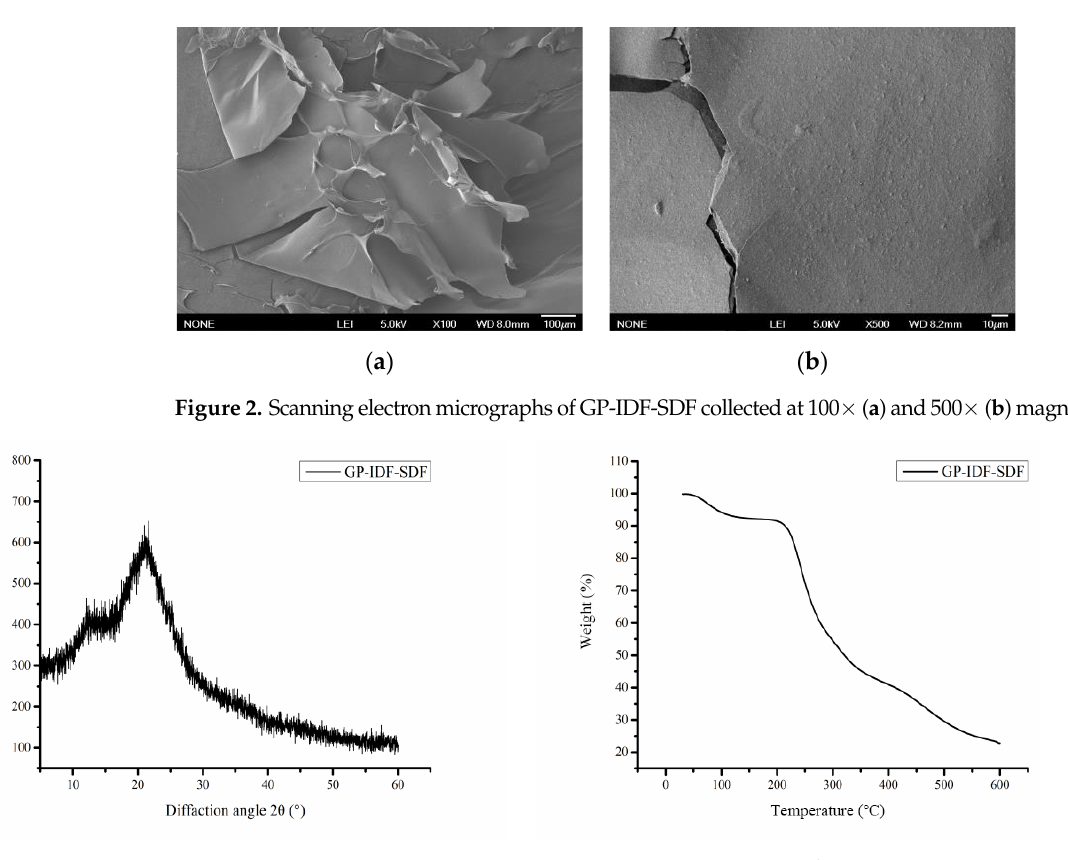
Figure 3. X-ray diffraction patterns ( a ) and thermal properties ( b ) of